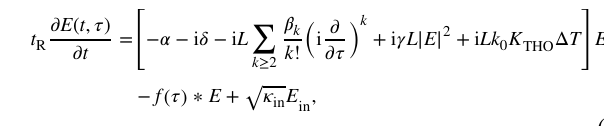
𝜅 = 0.0194 . 𝛿 scans linearly starting from − 0.0041 at a speed in √